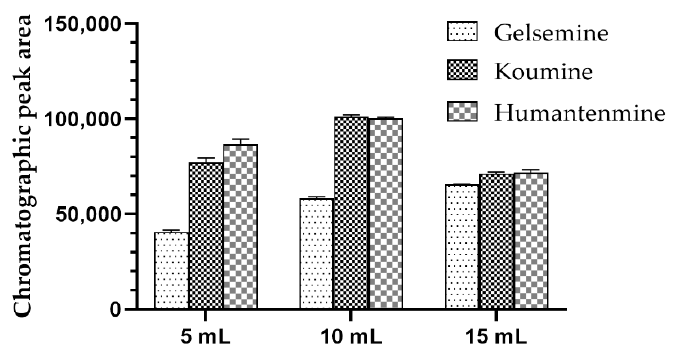
Figure 2. Comparison of the effects of 5 mL, 10 mL and 15 mL of flush solvent.